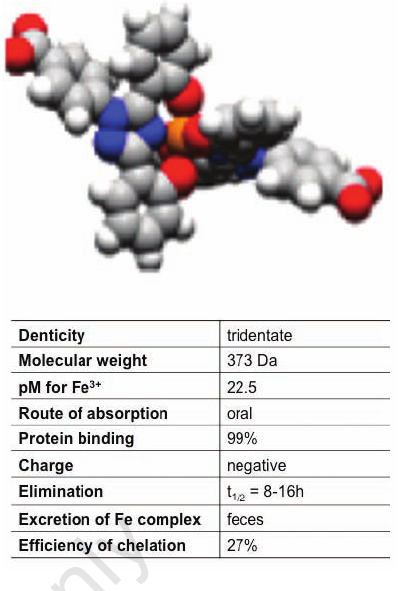
Figure 8. Structure of the deferasirox. Two molecules of deferasirox bind one atom of